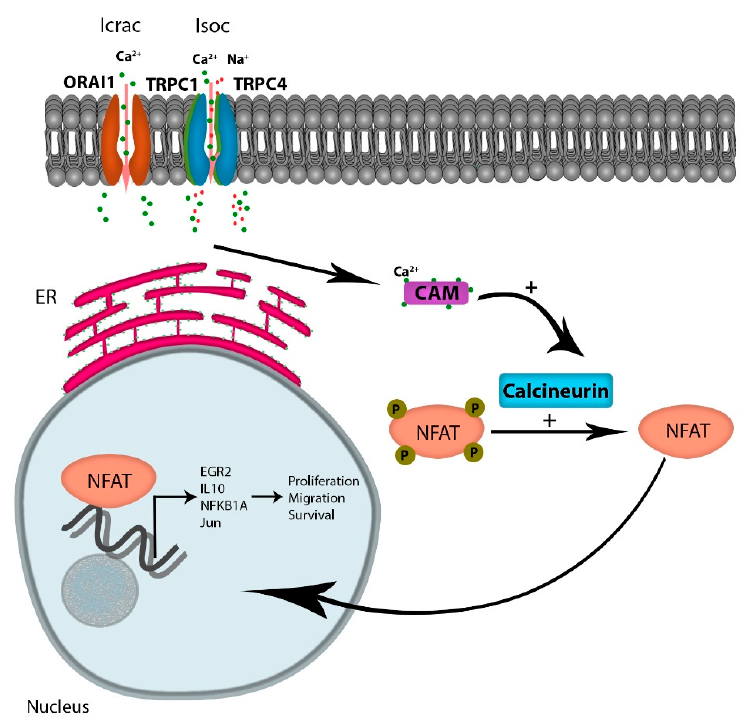
Figure 2. Ca 2 + entry through SOCE activates NFAT activation: Ca 2 + entry through the Icrac channel binds calmodulin, leading to the activation of the phosphatase protein calcineurin, activating the transcription factor NFAT. Active NFAT is translocated to the nucleus, regulating the expression of genes promoting proliferation, migration, and survival.